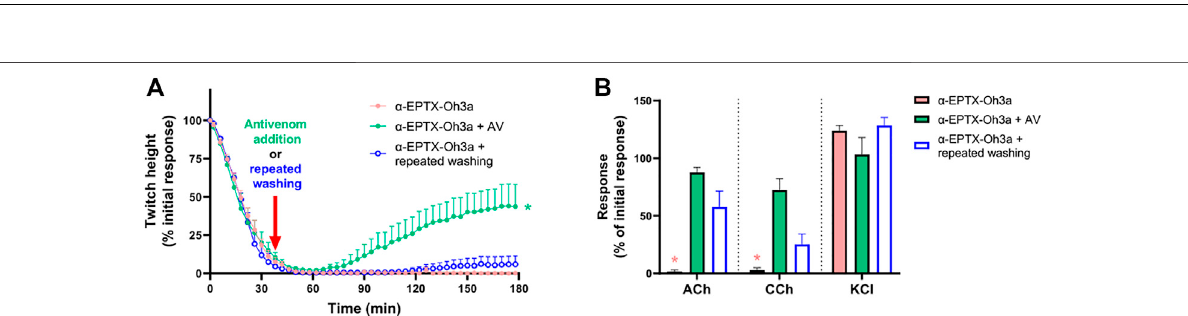
FIGURE 6 | The effect of α -elapitoxin-Oh3a (100 nM) in the absence and presence of Thai Red Cross Society King Cobra antivenom (AV; at the recommended concentration; 1 ml/0.8 mg) on (A) indirect twitches and (B) responses to exogenous agonists ACh (1 mM), CCh (20 µM) and KCl (40 mM) in the chick biventer cervicis nerve-muscle preparation. * p < 0.05, signi fi cantly different from (A) α -elapitoxin-Oh3a alone at 60 min (unpaired t -test; n = 4) or (B) pre-toxin response to same agonist (paired t -test, n = 4).